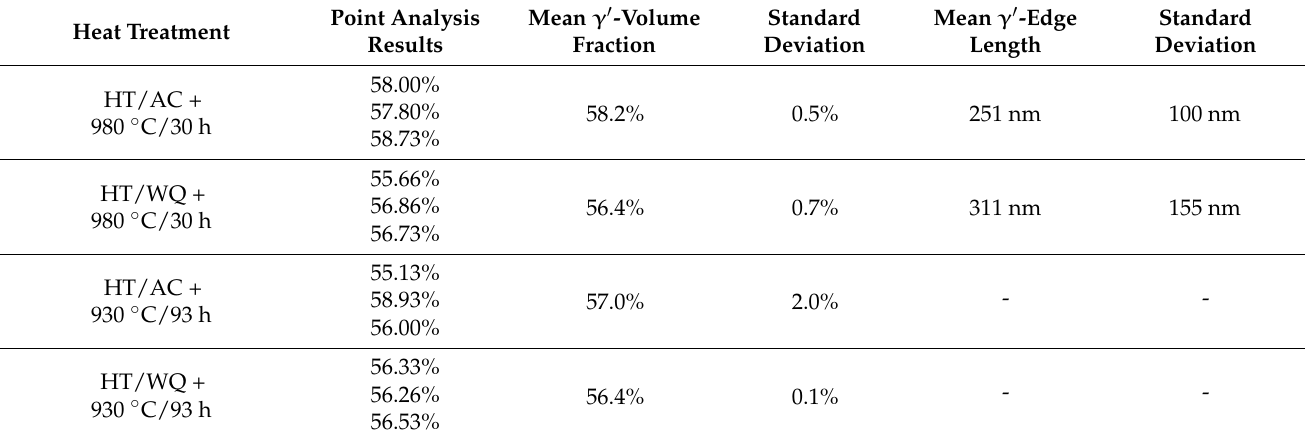
Table 5. γ (cid:48) -edge length and γ (cid:48) -volume fraction of the AC and WQ samples with additional heat treatment at 980 ◦ C and 930 ◦